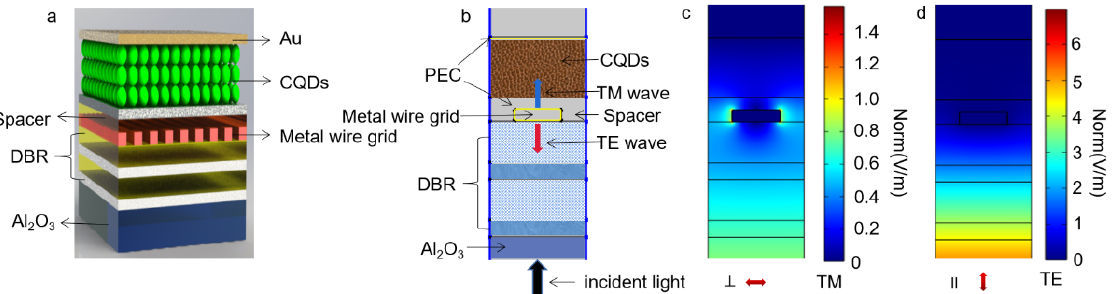
Figure 1. Architecture of resonant cavity-coupled Colloidal quantum-dot detectors with polar ization sensitivity. ( a ) Structure schematic and ( b ) simulation model of Resonant cavity-coupled Colloidal quantum-dot detectors with polarization sensitivity. Electric field distribution of ( c ) TM waves and ( d ) TE waves.